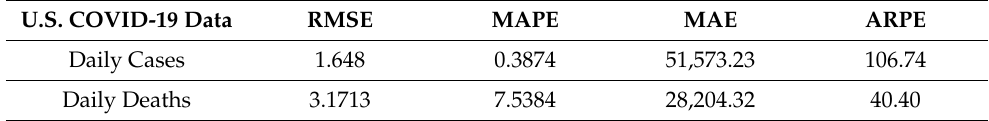
Table 10. Results from system of Γ ( a , b ) OU model.